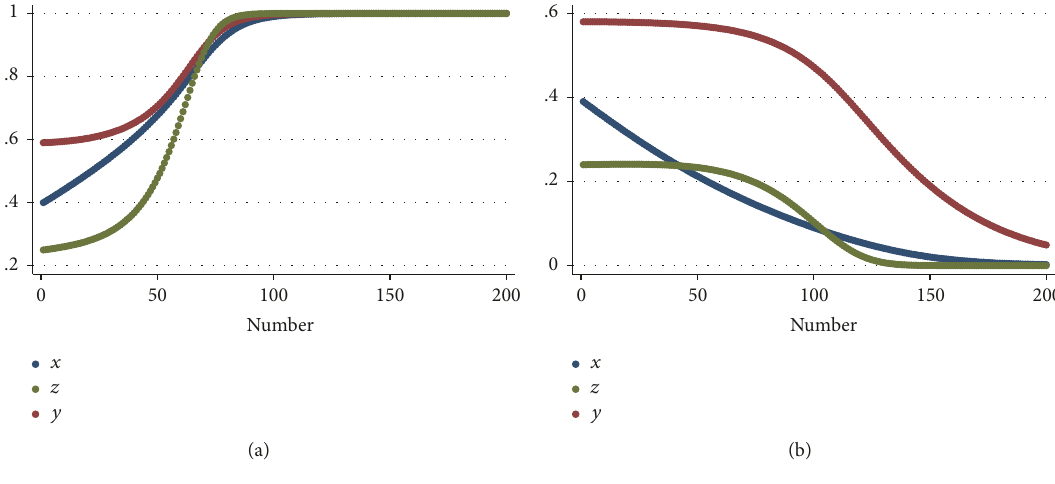
Figure 4: Simulation results when 𝑑